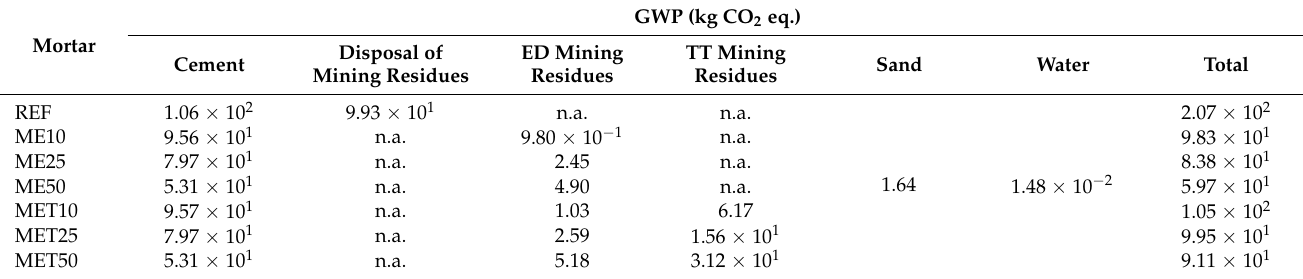
Table A2. Environmental impacts in the Global Warming Potential category, from the production of 1 t of mortars with cement and treated mining residues as binder constituents.